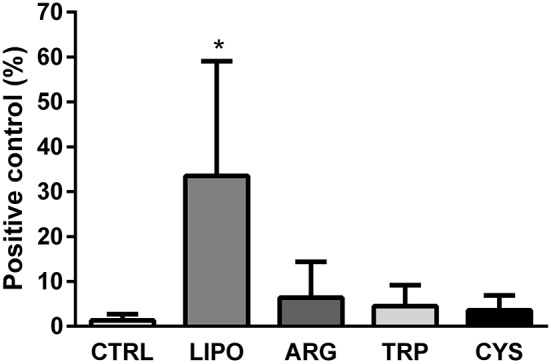
eGFP gene delivery on lung tissue. eGFP RNA levels measured in the lungs of animals that received liposomes conjugated with a DNA plasmid containing the eGFP gene (LIPO, ARG, TRP, and CYS groups), or the free DNA plasmid in vehicle (CTRL). Values are given as percentage of expression in relation to positive eGFP transgenic animals samples (mean ± SD). *Significantly different from the CTRL, ARG, TRP, and CYS groups (P < 0.05).